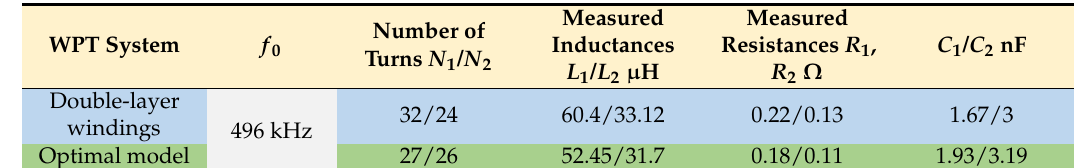
Figure 20. ( a ) Pulse-width modulation (PWM) signals; ( b ) input and output (orange) voltages for the optimal model at α = 0°. Table 4. Measured values.